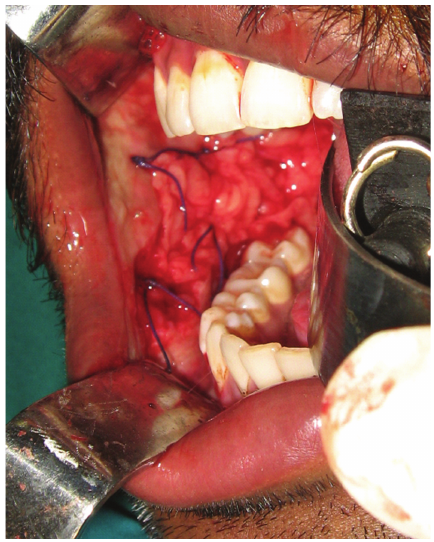
Figure 6: After 1 week. Table 1: Results of treatment: mouth